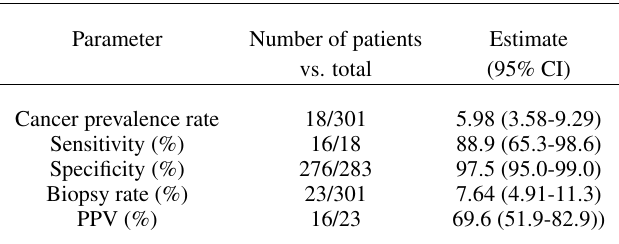
Table 2. Performance Characteristics of Molecular Breast Imaging at participant level